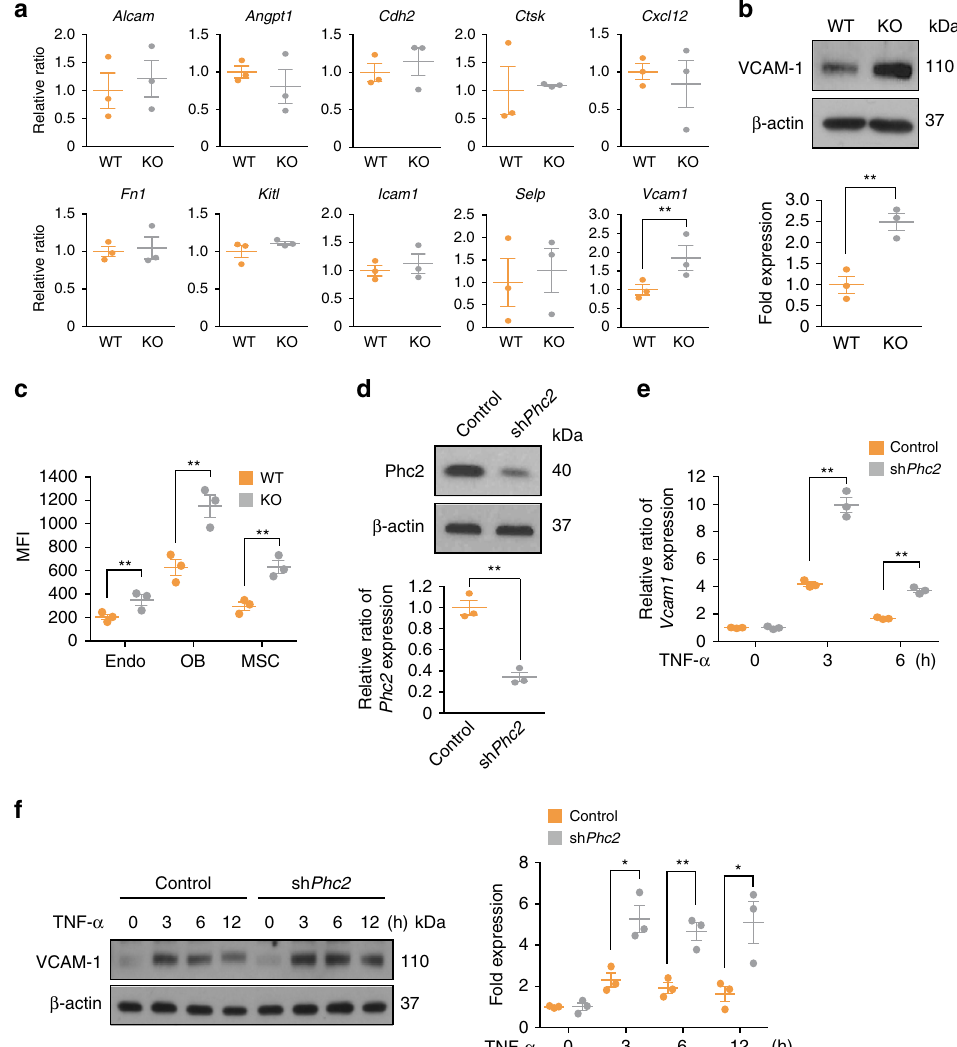
Fig. 5 Phc2 inhibits VCAM-1 expression in BMSCs. a mRNA expression patterns of genes related to HSPC mobilization in BM niches from WT and KO mice were accessed by qRT-PCR. n = 3. b Lysates from WT and KO BMSCs were immunoblotted to analyze VCAM-1 expression. n = 3. c Mean fl uorescence intensity (MFI) of VCAM-1 expression in BMSCs from WT and KO mice analyzed by fl ow cytometry. n = 3 Endo, endothelial cells; OB, osteoblasts;